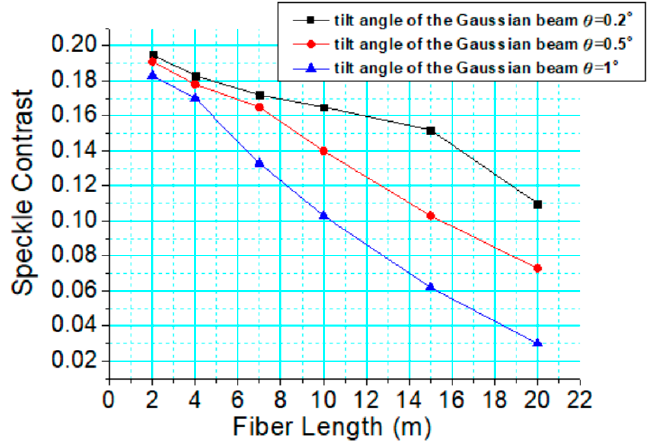
Figure 5. The speckle contrast from the image on the screen as a function of the incident angle θ = 0.2°, 0.5°, and 1° of the Gaussian beams with multimode fibers of total length L = 2, 4, 7, 10, 15, 20